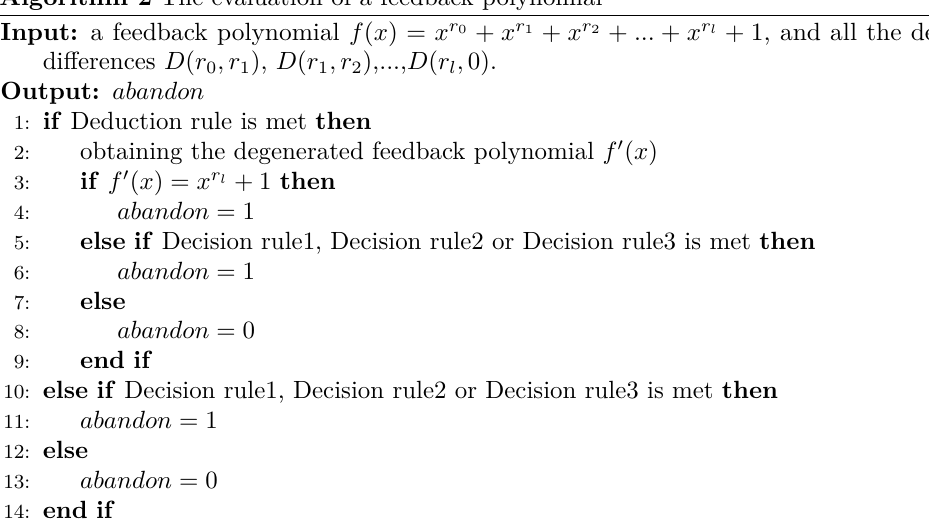
Algorithm 2 The evaluation of a feedback